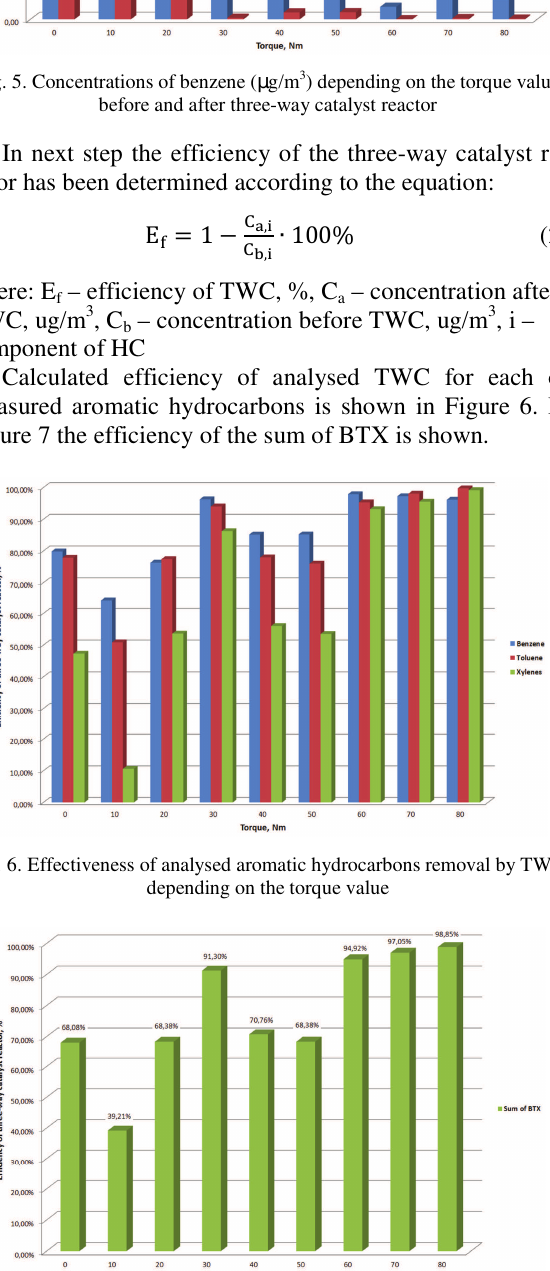
Fig. 7. Effectiveness of sum of BTX removal by TWC depending on the torque